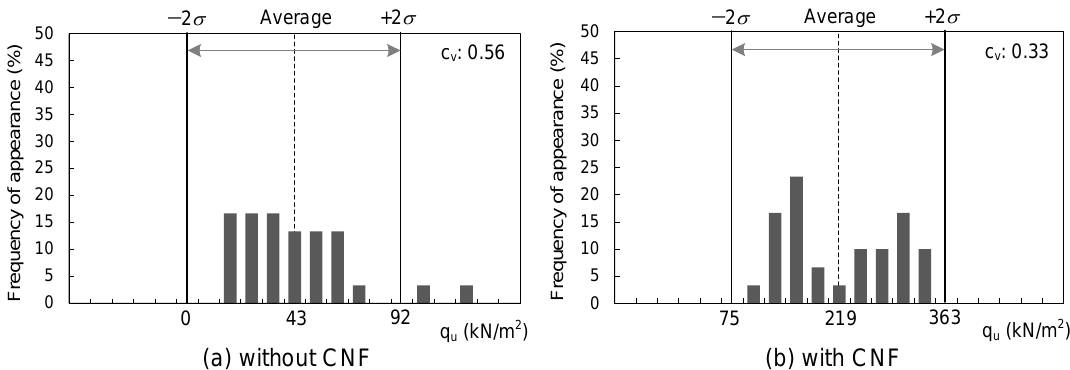
Figure 13. Frequency of appearance of unconfined compressive strength.